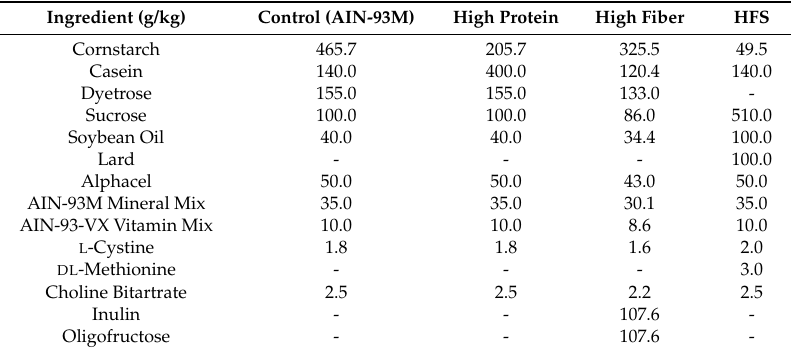
Figure 1. Schematic of study design for Reference ( A ) and Experimental ( B ) groups. Table 1. Maintenance and HFS Diet Compositions.